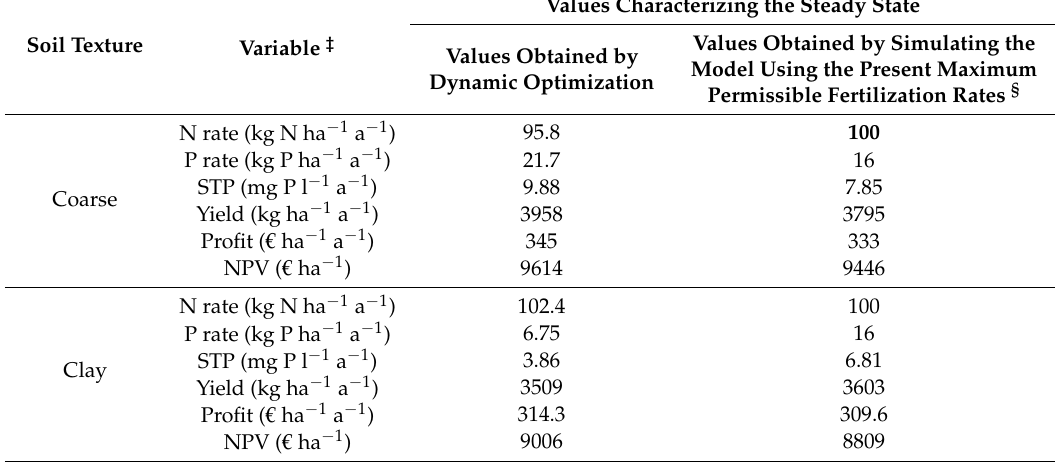
Table 5. Steady states obtained by applying economically optimal fertilization rates and the maximum permissible fertilizer rates of the voluntary agro-environmental scheme in Finland † .